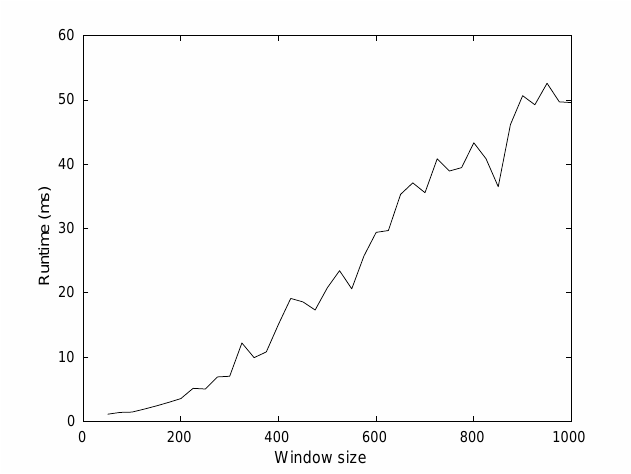
Figure 8. Average runtime to compute a single window.